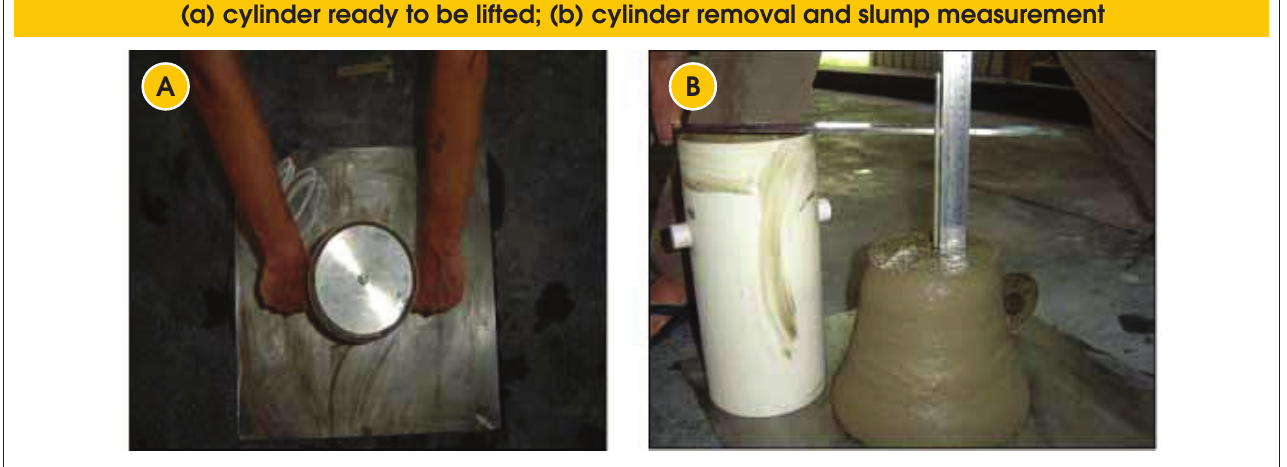
Figure 6 – Test procedure steps used for the method of Pashias: